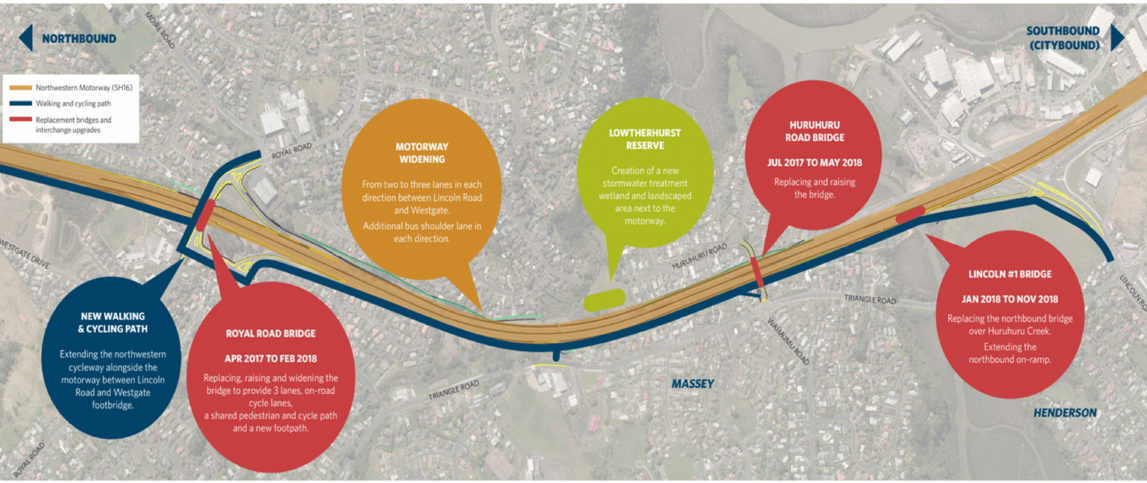
Figure 3. Urban Road Upgrade project plan [58].